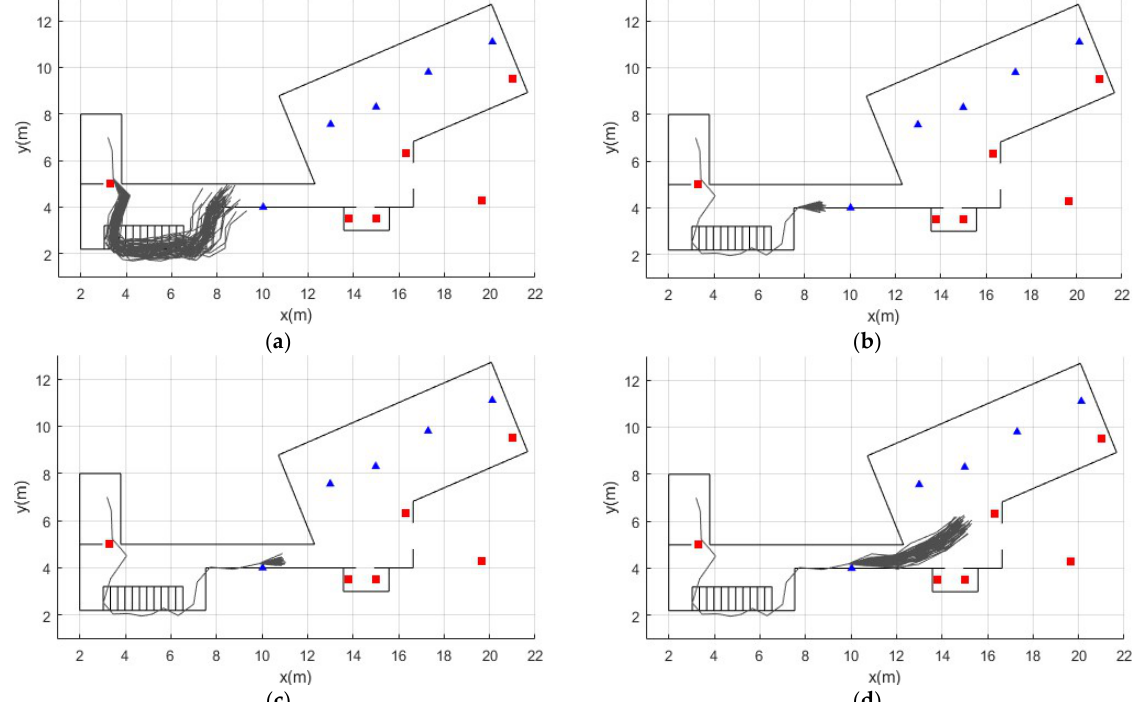
Figure 5. Example of obtaining a trajectory with the particle filter. Blue triangles represent stationary beacons. Red squares represent active and mobile beacons. ( a ) The person walks from the second floor into the corridor. In the prediction phase, the filter estimates the possible trajectories, denoted by dark gray lines. ( b , c ) the person enters the range of a stationary beacon placed in the corridor. The particles are updated with the RSSI data from that beacon, and the resampling process is exe- cuted. The filter converges in a single trajectory ( d ). The person continues on his way to the kitchen. The process is repeated .